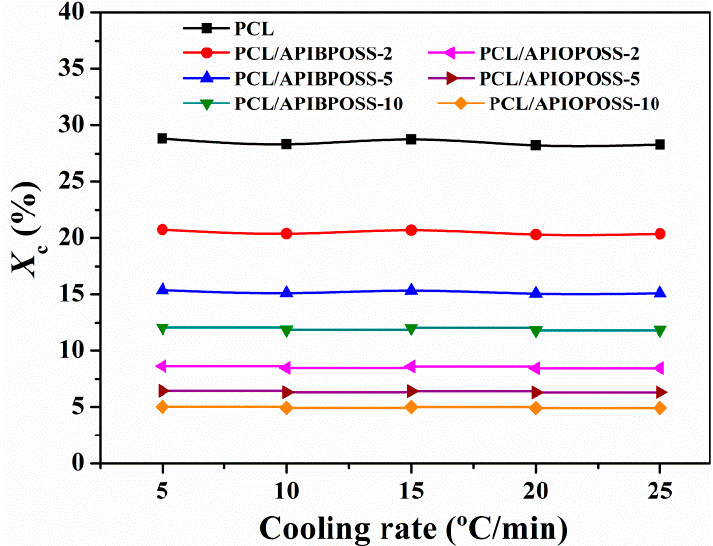
Figure 7. Degree of crystallinity as a function of cooling rate for PCL and PCL/POSS nanocomposites.